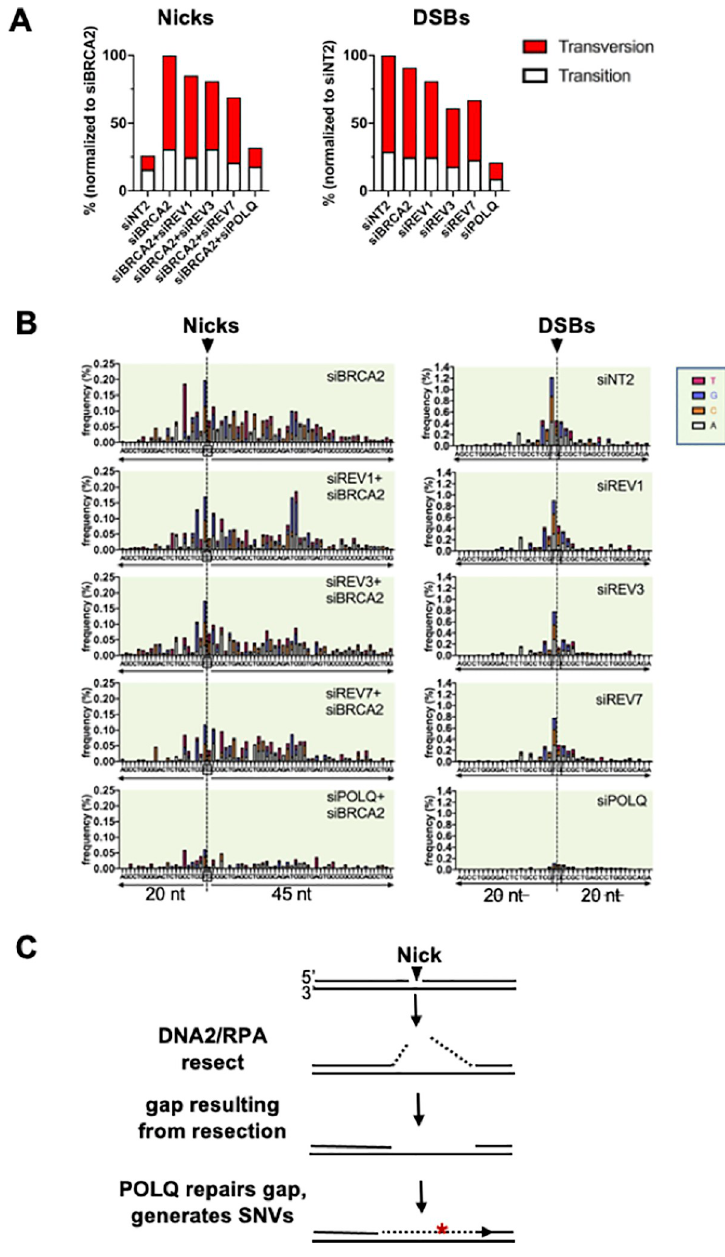
Fig 7. Single-nucleotide variants (SNVs). (A) Frequencies of SNVs at nicks and DSBs in the CD44 gene of U2OS cells depleted for indicated factors. To facilitate comparison of effects of different factors at nicks and DSBs, SNV frequencies were normalized to siBRCA2- or siNT2-treated cells, respectively, after subtraction of the background SNV frequency (0.26%) established by analysis of DNA from cells not targeted for cleavage by Cas9D10A. (B) Maps of positions and spectra of SNVs within the indicated 65 nt region spanning nicks or DSBs in cells depleted for indicated factors. The colored bar represents SNVs at each reference position: A, gray; C, orange; G, blue; T, red. (C) Diagram of mutagenic repair by POLQ of a gap generated by 5’ resection mediated by DNA2/RPA. Red asterisk indicates SNV; dashed lines, resected DNA.